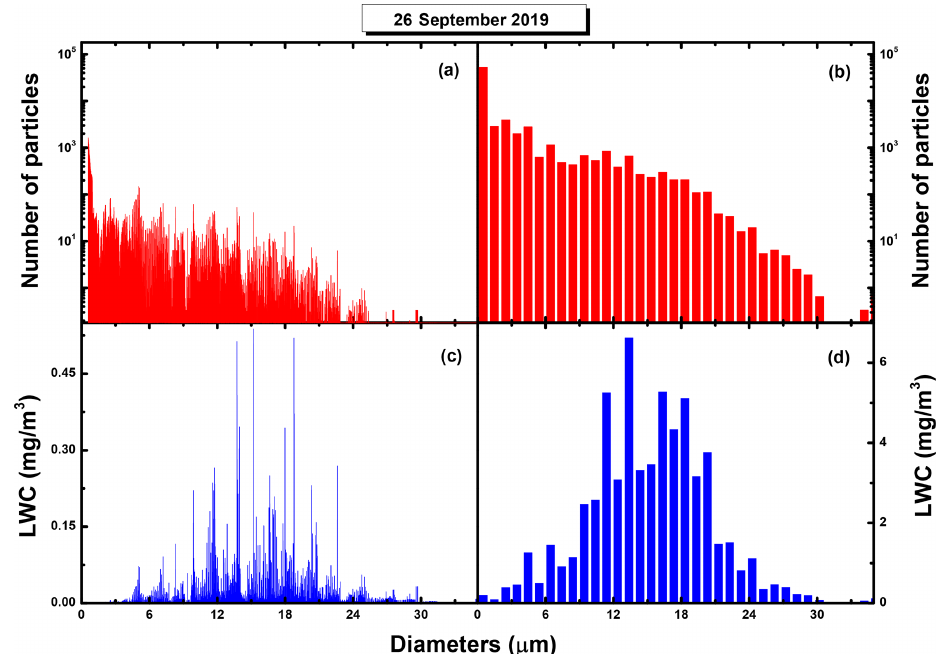
Figure 3. Number (a, b) and LWC (c, d) size distributions obtained from the post-flight analysis of PbP data recorded during a flight line performed on 26 September 2019, over some area of Romania. The diagrams (a) and (c) are detailed distributions and show a fine structure of size modes, which are “wiped” out if spread over coarser size grids, as seen on the histograms (b) and (d) constructed over a structure of 50 equal size bins. Nevertheless, these coarser representations allow for sufficient resolution to accurately compute various averages and are more convenient in evaluating maximal relative errors, as described in the next section. Note the unusual range of LWC values due to the small amounts of liquid water counted in each division of the very fine grid of diameter values. Also, in panel (d) , note that the levels of the LWC distribution are higher than those of panel (c) as they collect the contributions of particles from larger divisions of diameter